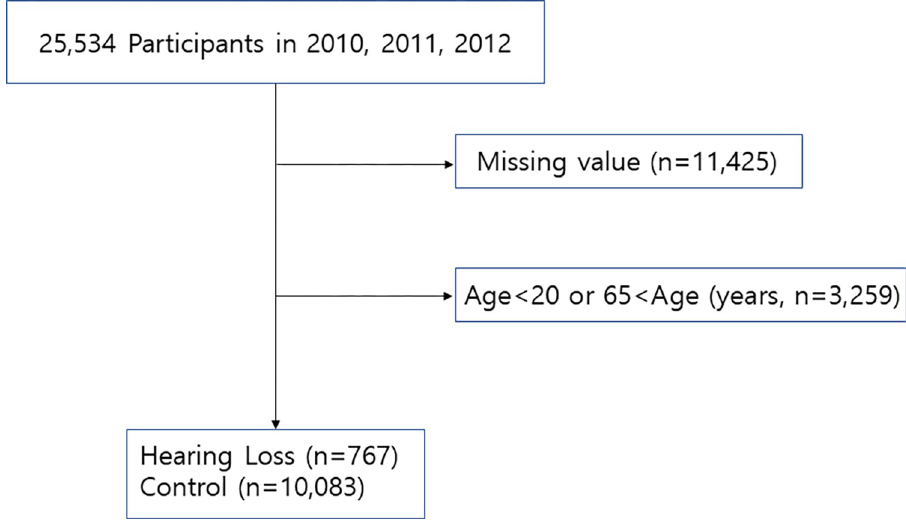
Fig 1. A schematic illustration of participant selection in the present